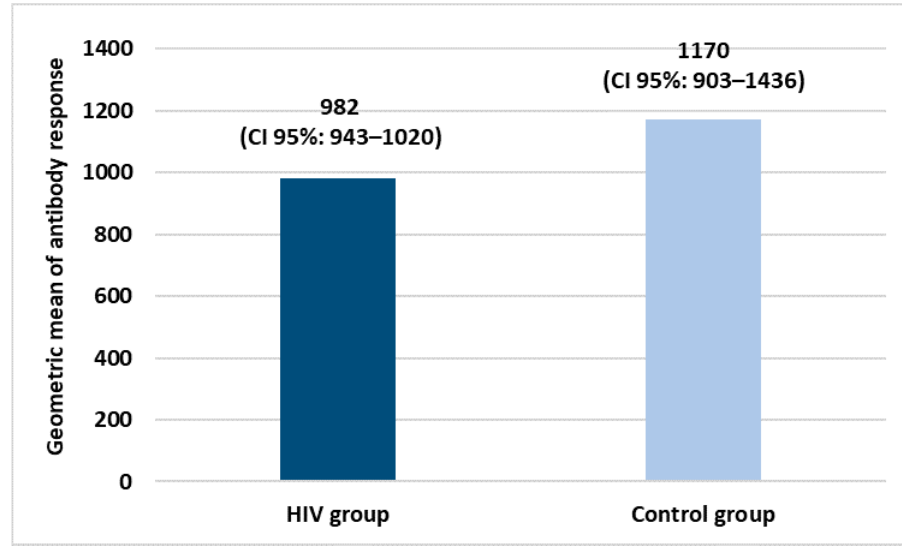
Figure 1. Geometric means of antibody response after COVID-19 vaccination primary cycle.